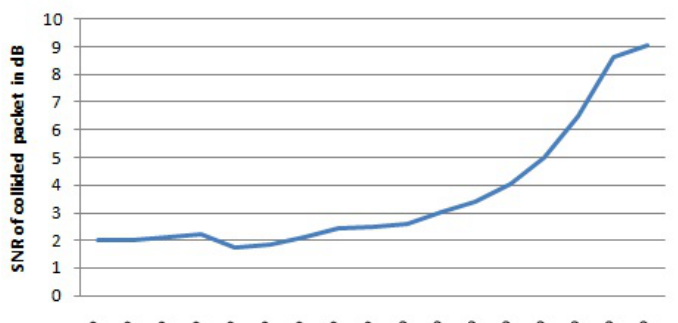
Figure 3. Average SNR value for received packets from the interfered transmitter for the first